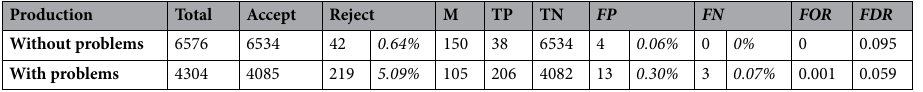
Table 9. Total products considered (Total), accepted products (Accept), rejected products (Reject), test duration in minutes (M), true positives ( TP ), true negatives ( TN ), false positives of the CNN model (FP), false negatives of the CNN model ( FN ), false omission rate ( FOR ) and false discovery rate ( FDR ) obtained with the pre-trained DenseNet161 in the real scenario considering two production situations: one without problems, and another one with problems. Percentages have been computed from total